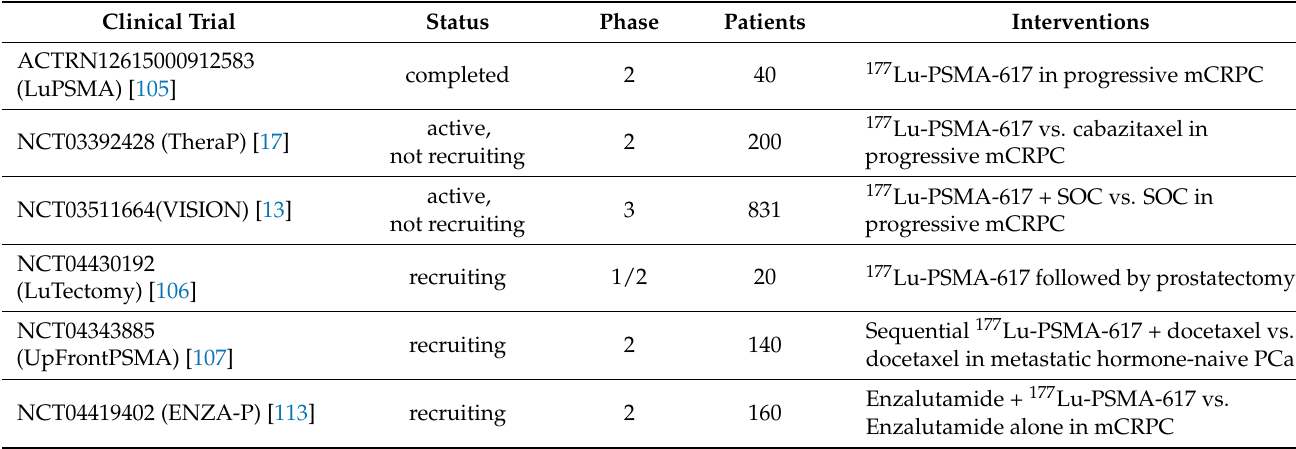
Table 5. Clinical trials of PSMA-targeted radioligand